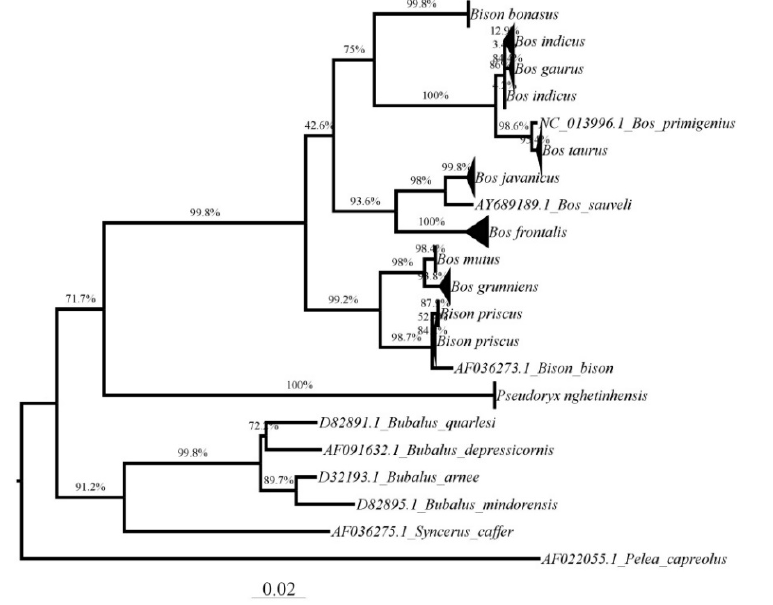
Fig. 3. Maximum Likelihood tree based on the Hasegawa-Kishino-Yano (HKY+G) distance using cytochrome b ( cytb ) sequences; the numbers on each branch correspond to the bootstrap support values. The tree was rooted with P. capreolus ; [{( Bi. bonasus )+ ( B. indicus + B. gaurus + B. indicus + B. primigenius + B. taurus )+ (( B. javanicus + B. sauveli )+ B. frontalis )+ (( B. mutus + B. grunniens )+ ( Bi. priscus + Bi. bison ))+ Pseudoryx nghetinhensis }+ {(( Bu. quarlesi + Bu. depressicornis )+ ( Bu. arnee + Bu. mindorensis ))+ Syncerus caffer